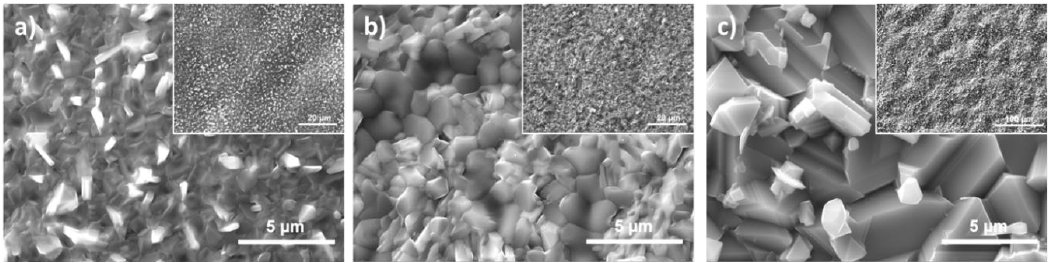
Figure 5. The surface oxides on specimens of grades ( a ) A1; ( b ) A2 and ( c ) A3 after the exposure for 64 h/1200 °C.